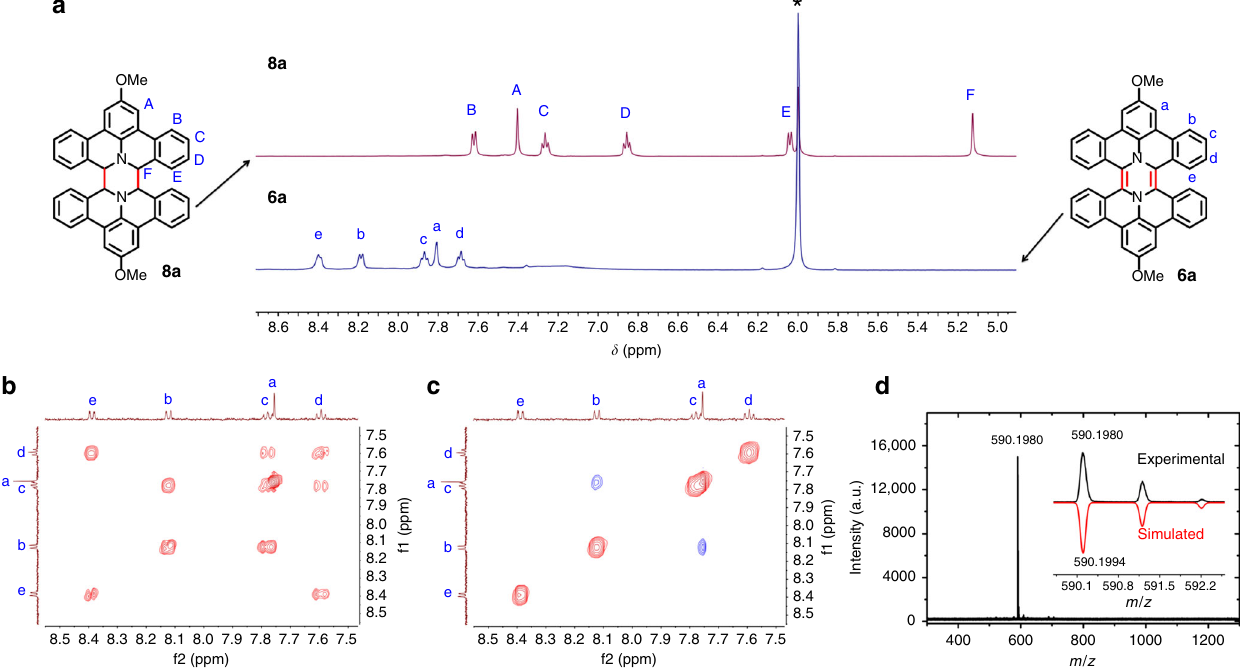
Fig. 3 Structural characterizations of the in situ generated diaza-HBP 6a . a 1 H NMR spectra of 8a and 6a together with their structural assignments (*C 2 HDCl 4 ). Compared to precursor 8a , the signals of 6a were down- fi eld shifted, corroborating the extension of the π -conjugation. b Aromatic region of the 1 H – 1 H COSY spectrum of 6a in C 2 D 2 Cl 4 . c Aromatic region of the 1 H – 1 H NOESY spectrum of 6a in C 2 D 2 Cl 4 . d High-resolution MALDI-TOF MS spectrum of 6a , with an inset showing its experimental (black line) and simulated isotopic distributions (red line)